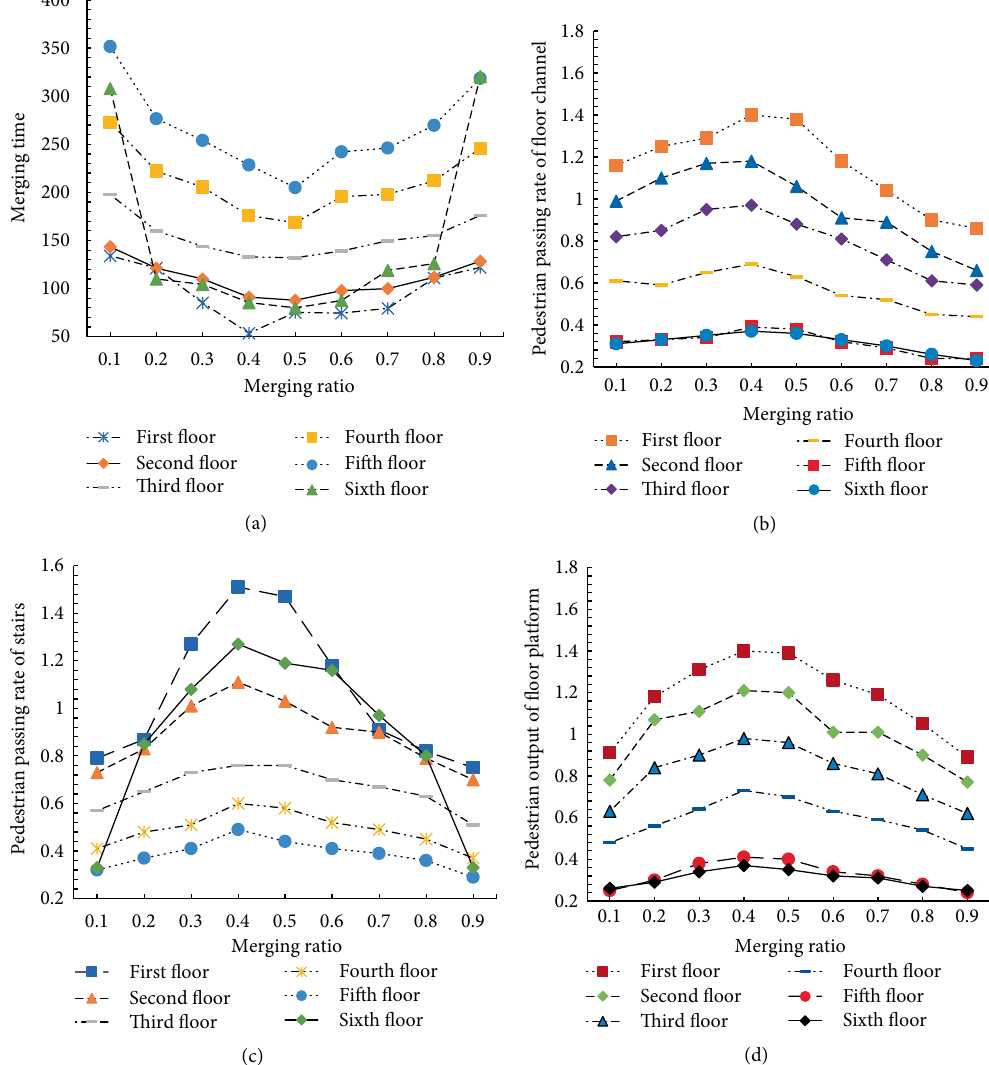
Figure 6: Influence of merging ratio for the merging flows time, the passing rate of floor channel, the passing rate of stairs, and the output rate of floor platform for different